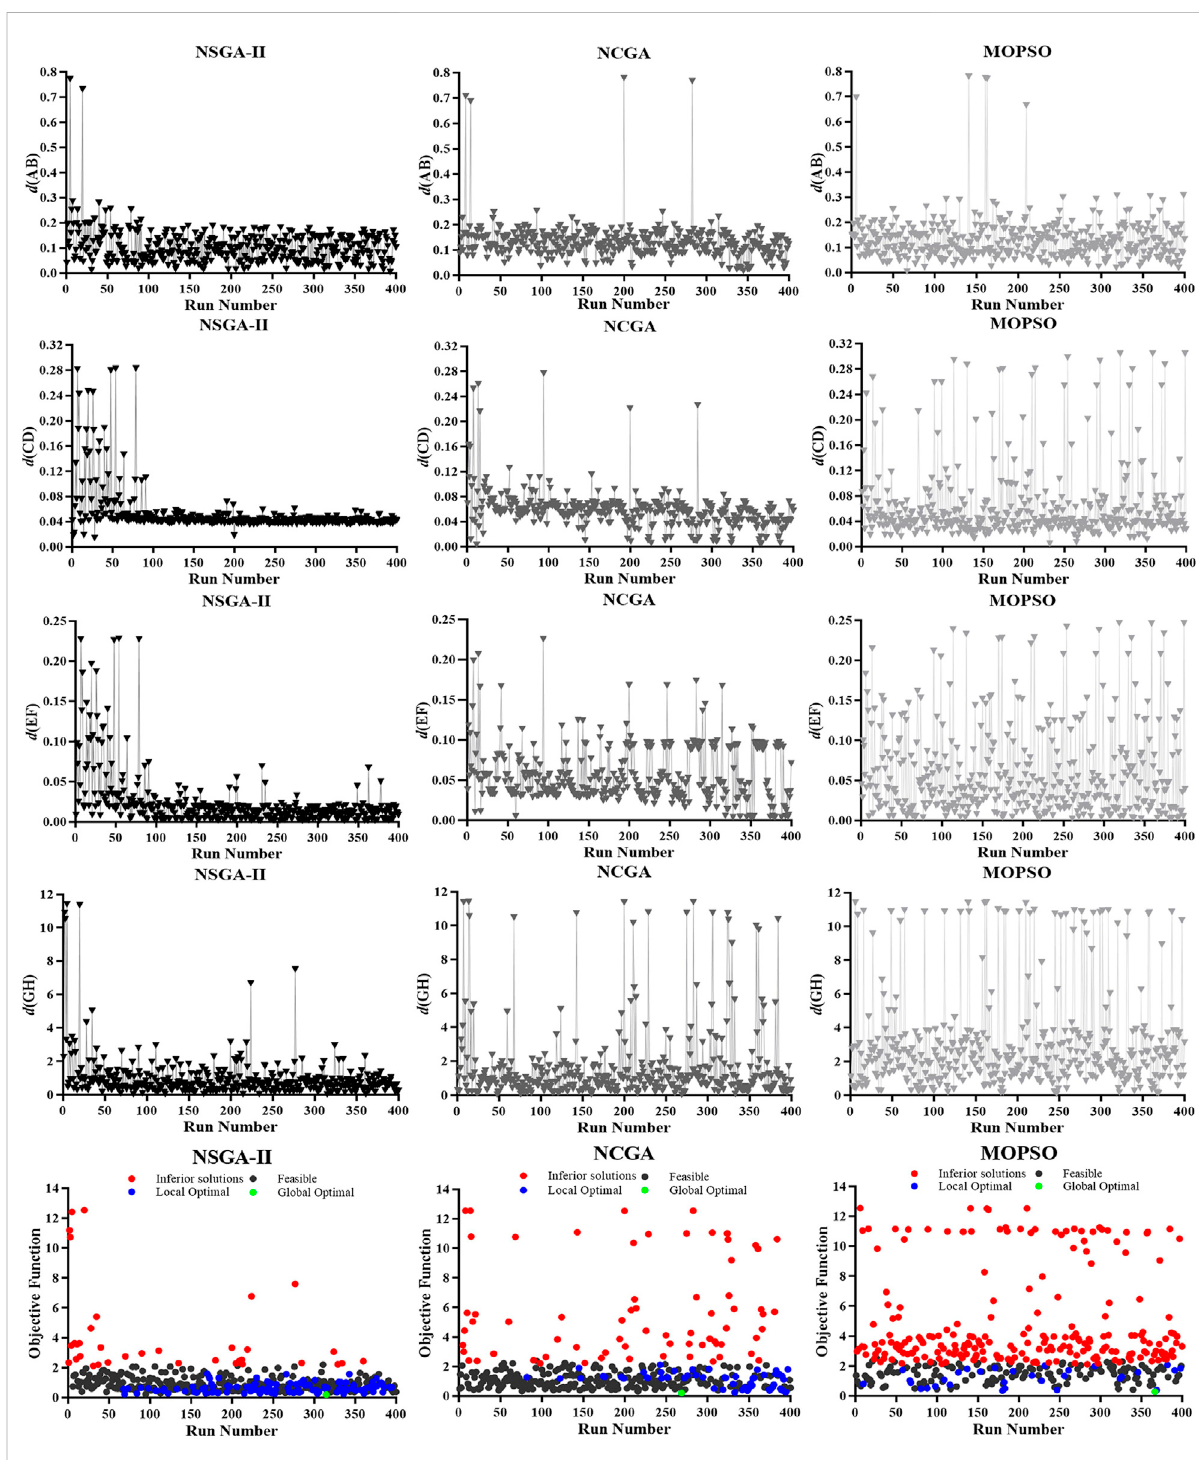
FIGURE 7 Simulation histories of different algorithms. The three columns from left to right are NSGA-II, NCGA, and MOPSO. The fi ve rows from top to bottom are d (AB), d (CD), d (EF), d (GH), and d (objective). The x -axis of each Pareto graph indicates the number of runs, and the y -axis indicates the value of each sub objective function and the objective